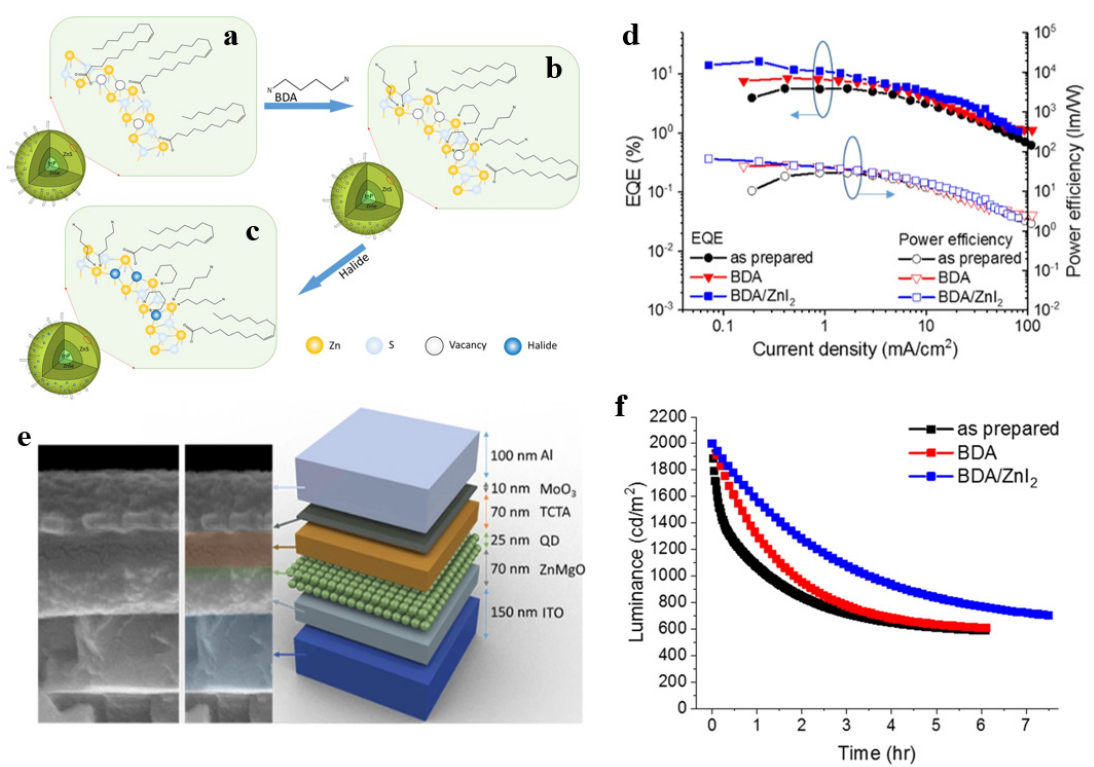
Figure 10. Schematic diagram of the synergistic passivation of InP green QDs by BDA and zinc halide. ( a ) Green InP/ZnSe/ZnS QDs with oleic acid ligands. ( b ) InP QDs modified with BDA consisting of two amino groups. ( c ) InP QDs were further modified by passivation of various zinc halides. ( d ) Variations of EQE and power efficiency as a function of the current density. ( e ) The SEM image of the interlayers cross − section and corresponding device structure. ( f ) Operational lifetimes of InP QLEDs under a condition of 2000 cd/m 2 . Reprinted with permission from Ref. [24]. © 2021, The Author(s).